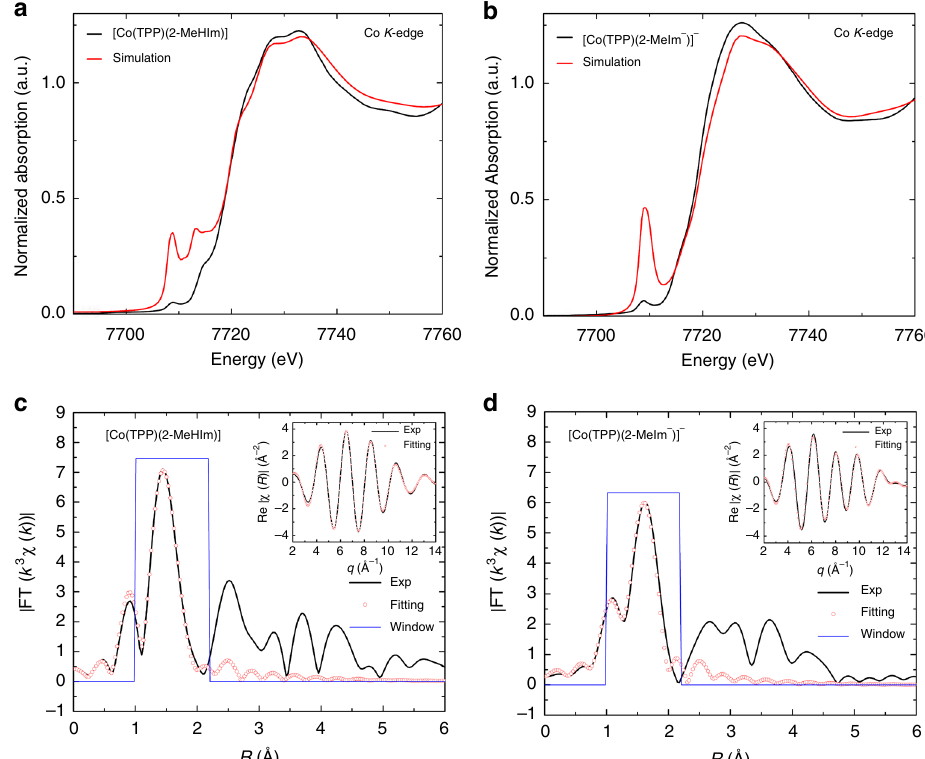
Fig. 4 Comparisons of experimental and theoretical Co K -edge XANES and EXAFS. a K -edge XANES of [Co(TPP)(2-MeHIm)] (black line: Experiment, red line: Simulation). b K -edge XANES of [Co(TPP)(2-MeIm − )] − (black line: Experiment, red line: Simulation). c EXAFS of [Co(TPP)(2-MeHIm)] (black line: Experiment, red circles: Fitting). d [Co(TPP)(2-MeIm − )] − (black line: Experiment, red circles: